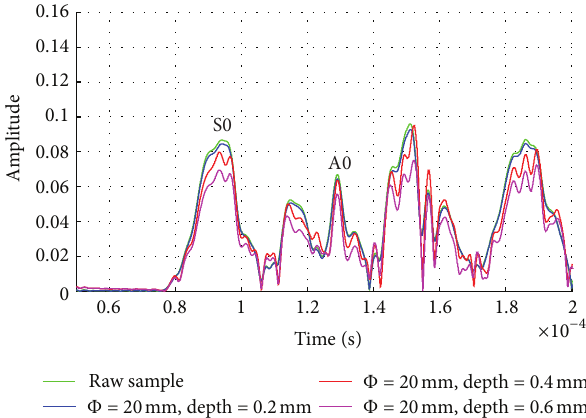
Figure 8: Envelope of each signal obtained from each